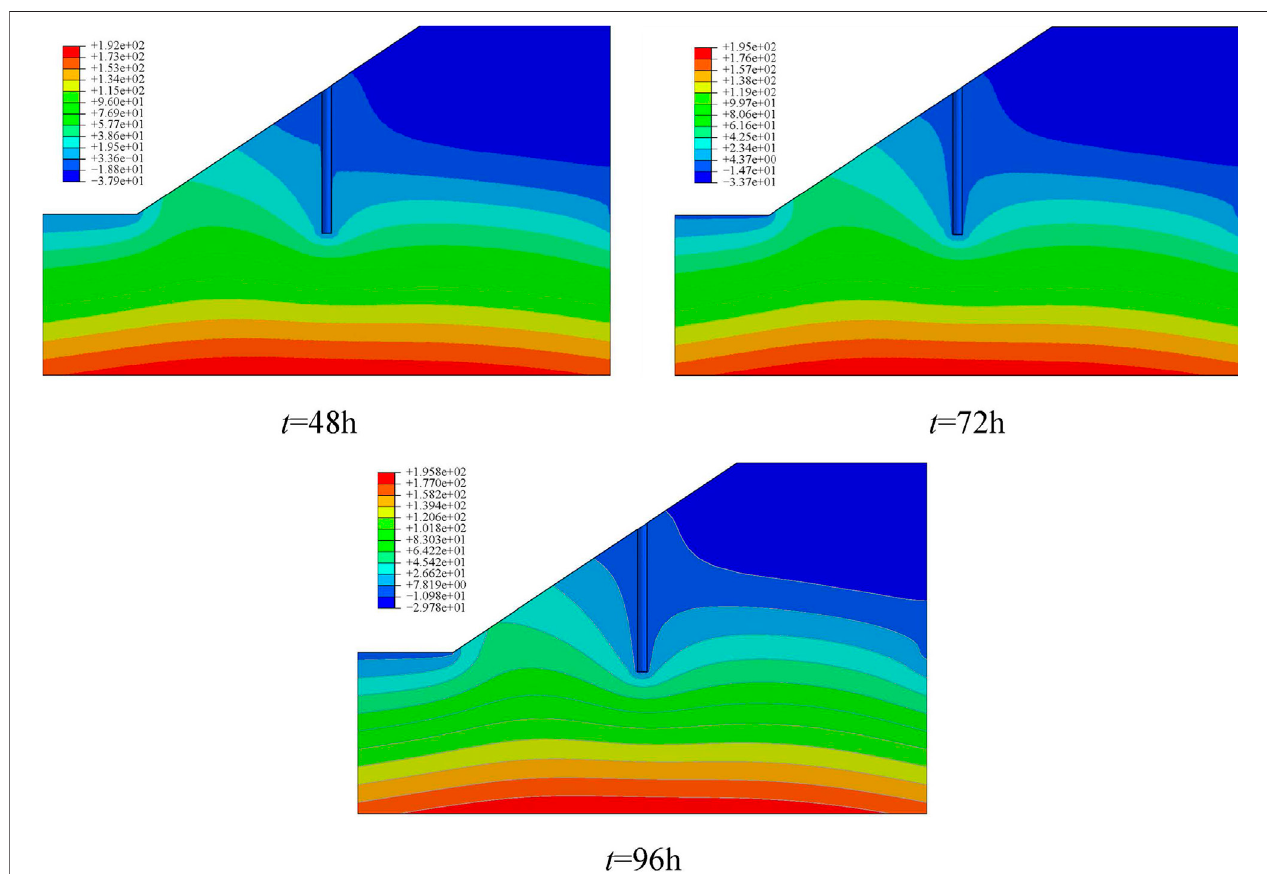
FIGURE 4 | Distribution of pore pressure at peak rainfall intensity for different rainfall